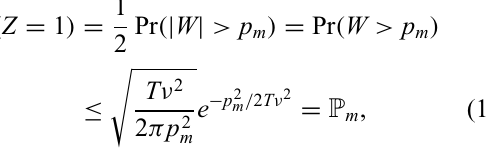
Algorithm 3. Subsampling and